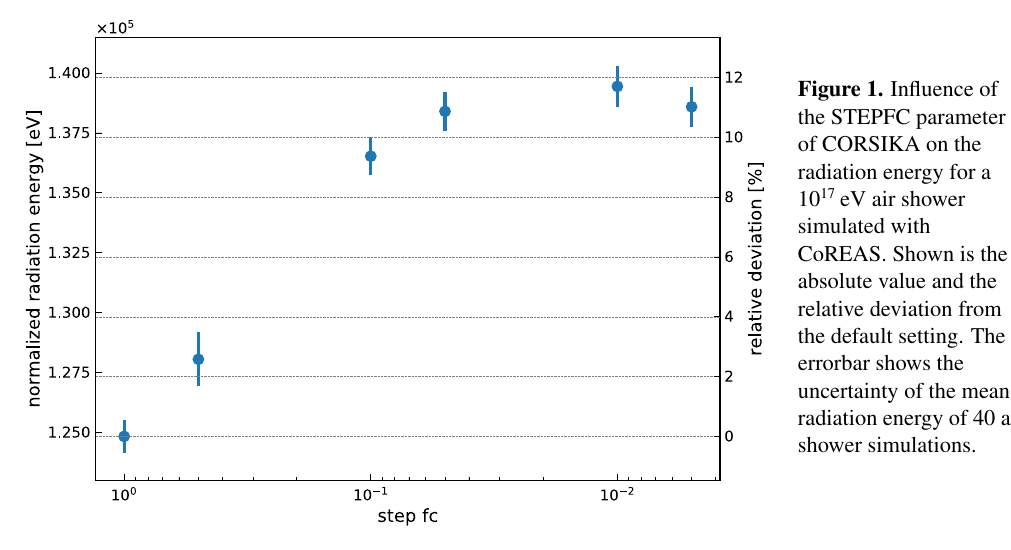
Table 1. Systematic uncertainties of the calculation of the radiation energy from the electromagnetic shower energy. Non-bold values taken from [3].